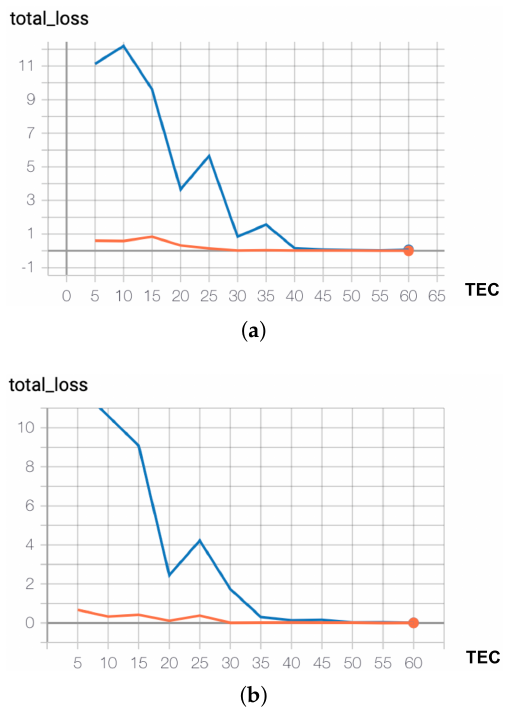
Figure 7. Learning curves: orange—train set loss, blue—validation set loss ( a ) Scenario 0 ( b ) Scenario